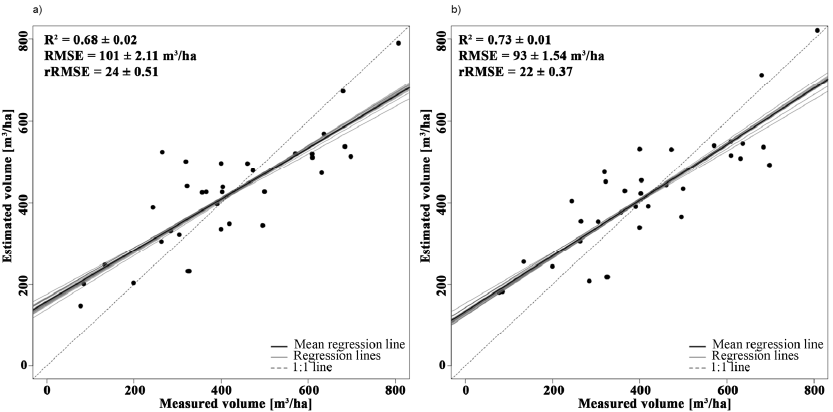
Figure 7. Agreement of estimated volume with in-situ data; ( a ) simple model based on a PVI index; ( b ) stepwise multiple regression model based on a combination of a band depth index and a PVI type index. The corresponding wavelengths of the indices are given in Table 5. Coefficient of determination (R 2 ± SD), root mean square error (RMSE ± SD), and relative root mean square error of prediction (RMSE% ± SD) are shown.